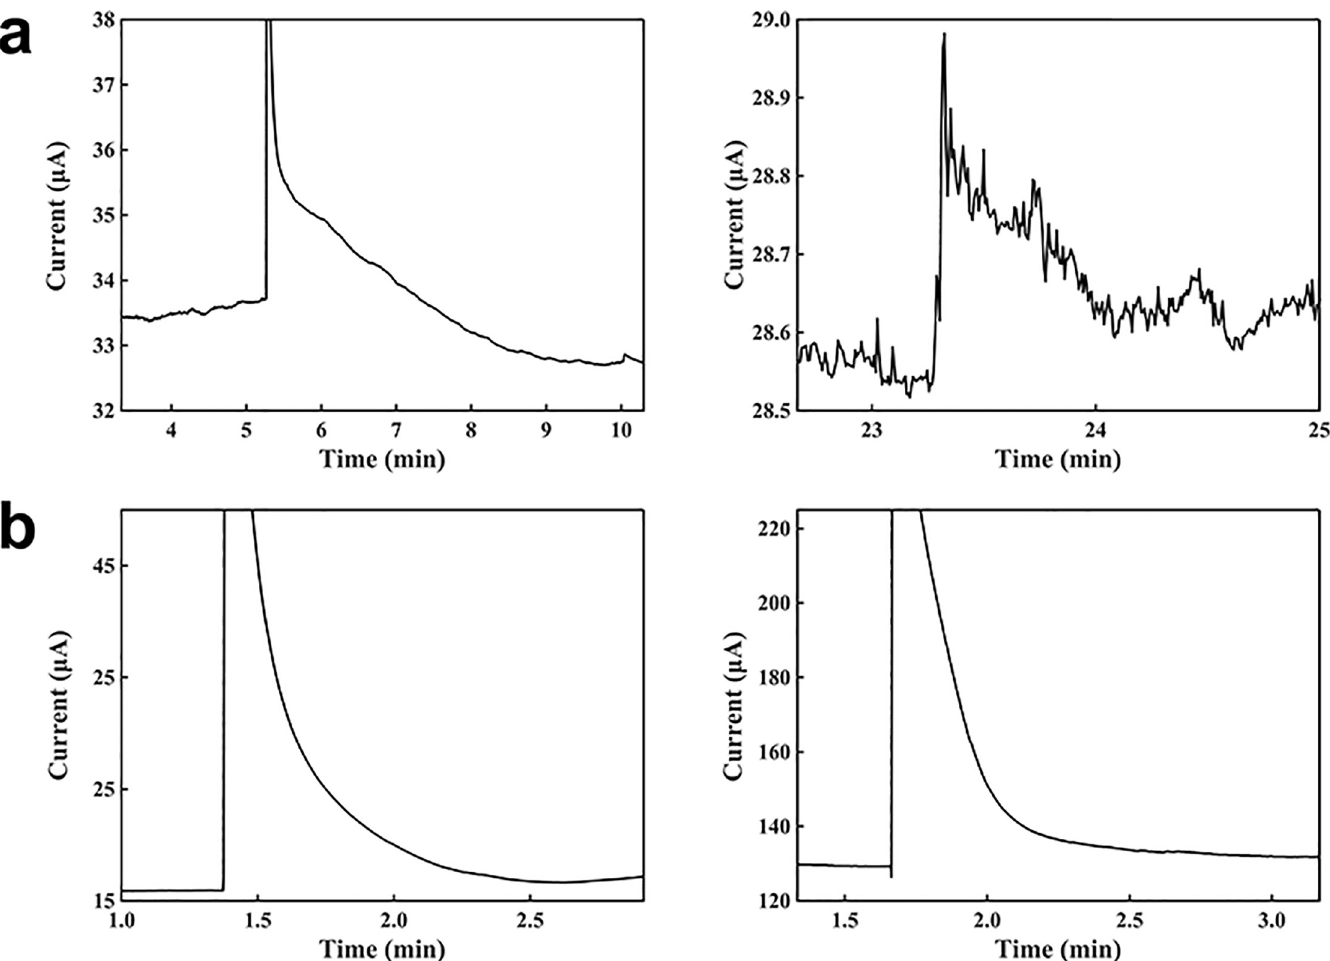
Fig 2. Study of a battery and a potentiostat for detecting H 2 O 2 at different voltages. (a) Signal response curves for H 2 O 2 using batteries at 1.5 V (left) and 3.0 V (right). (b) Signal response curves for H 2 O 2 using a potentiostat at 1.5 V (left) and 3.0 V (right). Buffer solution: 50 mM. H 2 O 2 concentration in the buffer: 0.05 mM.